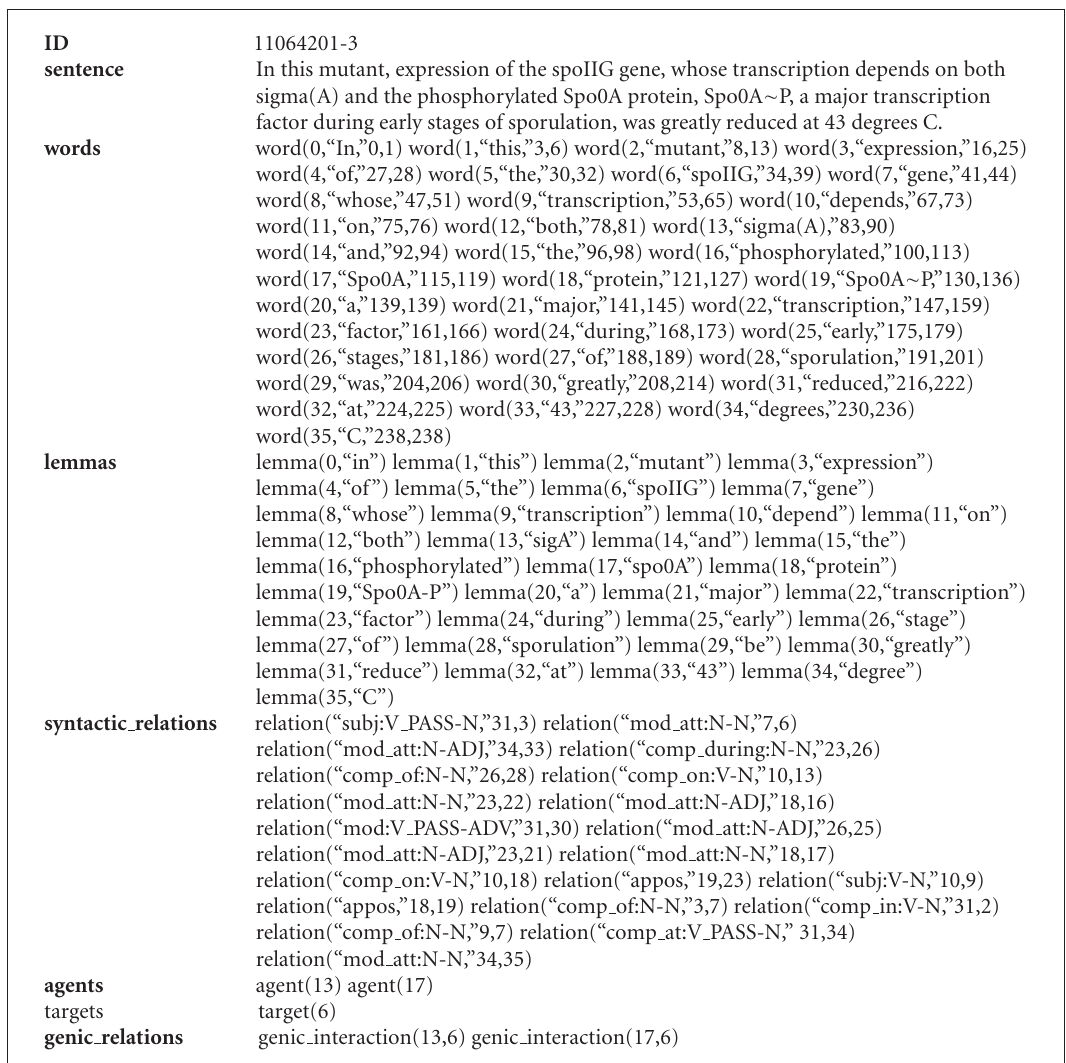
Algorithm 1: Example of LLL05 training